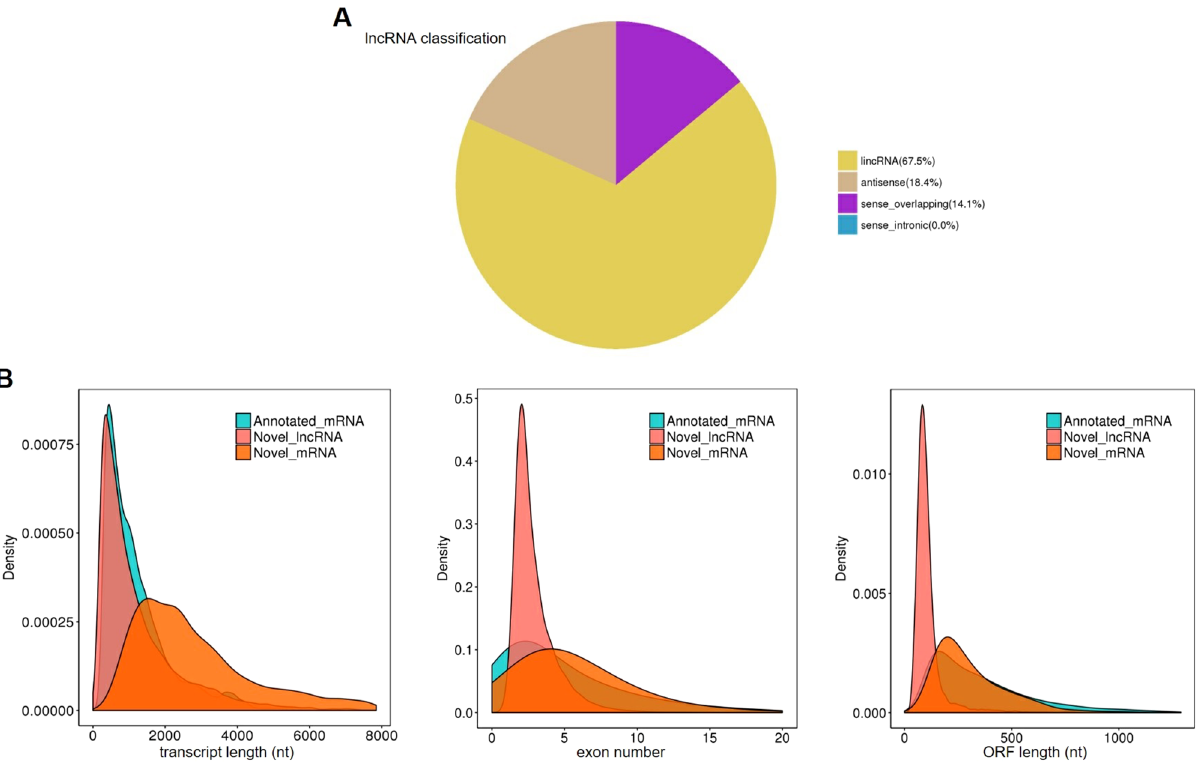
Figure 1. Prediction results and characteristics of lncRNAs. ( A ) lncRNAs classification; ( B ) comparison of length, number of exons and open reading frame between novel lncRNAs and mRNAs. Image generated with